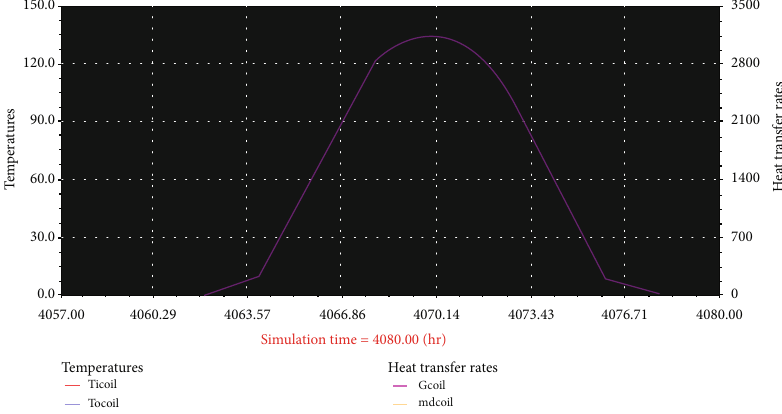
Figure 12: Thermal energy produced by the solar water heater system on June 18.